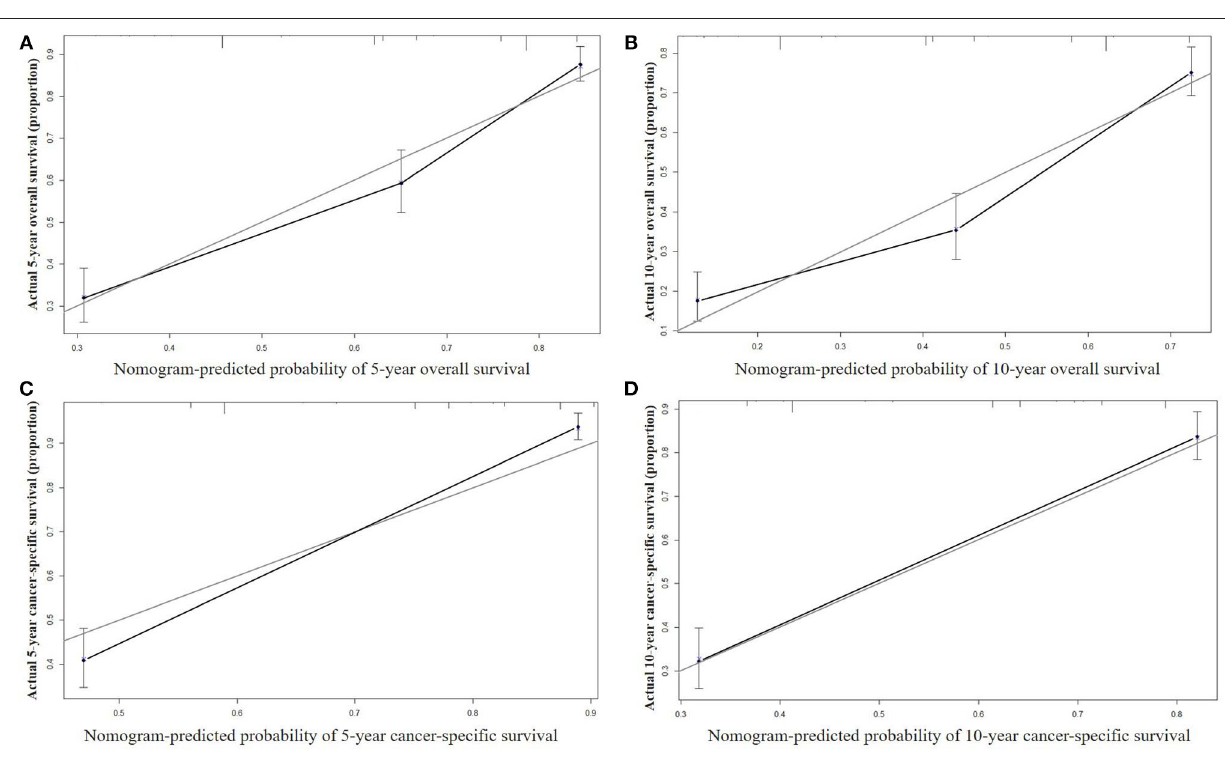
The nomogram is a pictorial display of prognosis prediction, which constitutes a significant part of clinical decision-making (22, 24). Nomograms provide rapid and simple prognostic information by integrating easily available and measurable